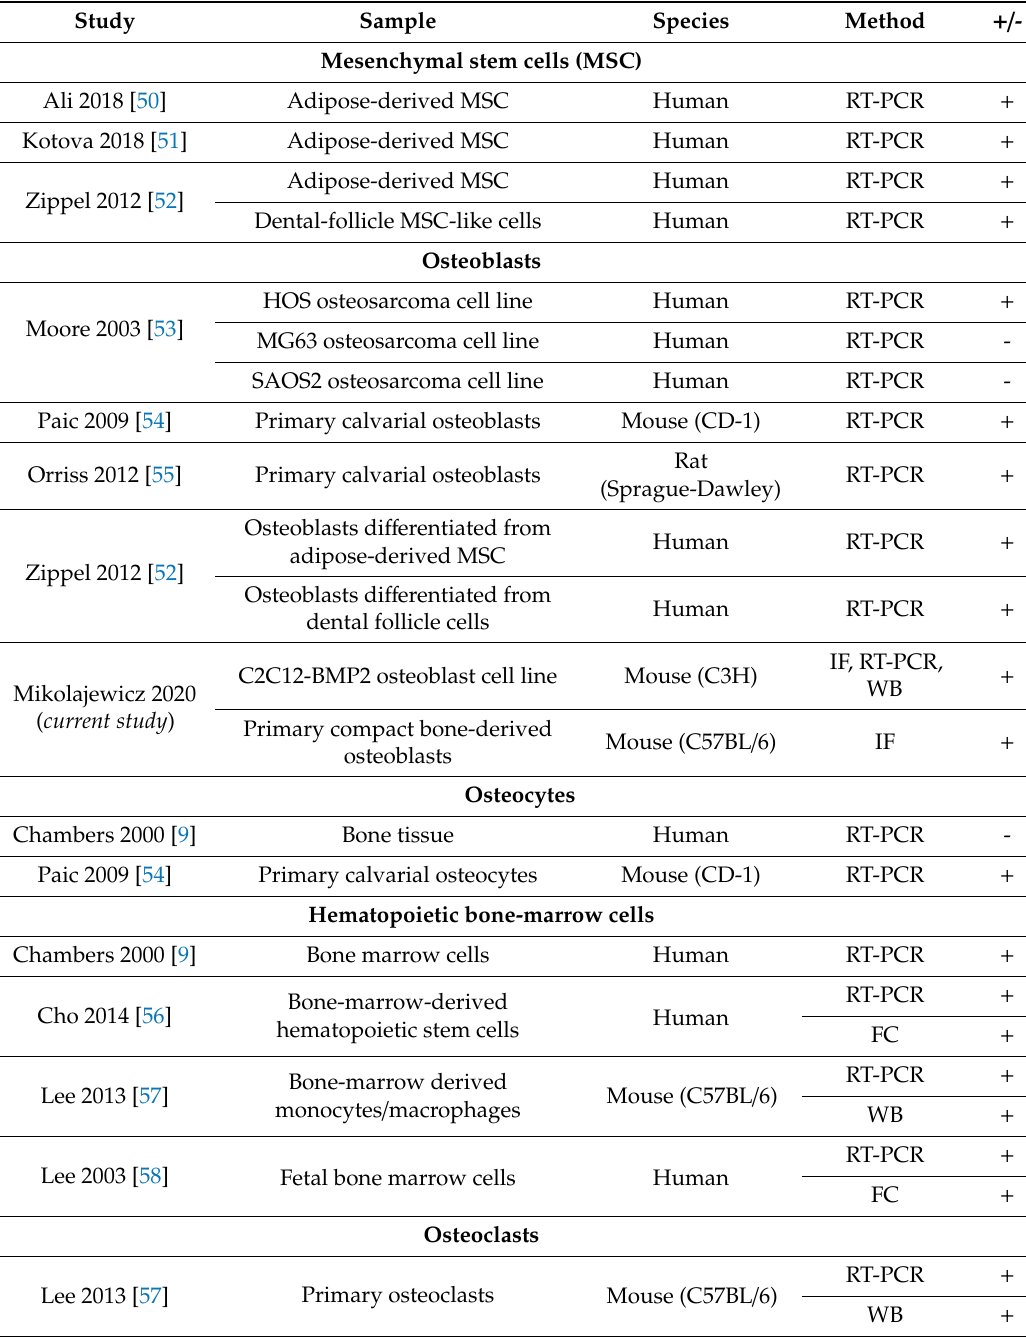
Table 1. P2Y 14 expression in bone. A rapid review of literature assessing the expression ( + ) or absence ( − ) of P2Y 14 in bone-residing cells. The search strategy is provided in Table S1. FC: flow cytometry,